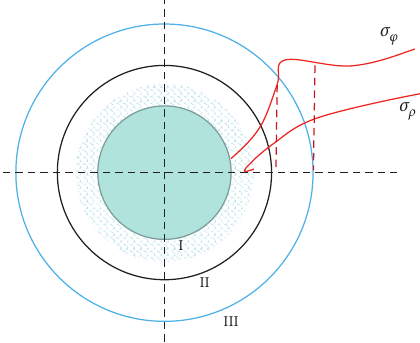
Figure 2: Stress state after tunnel